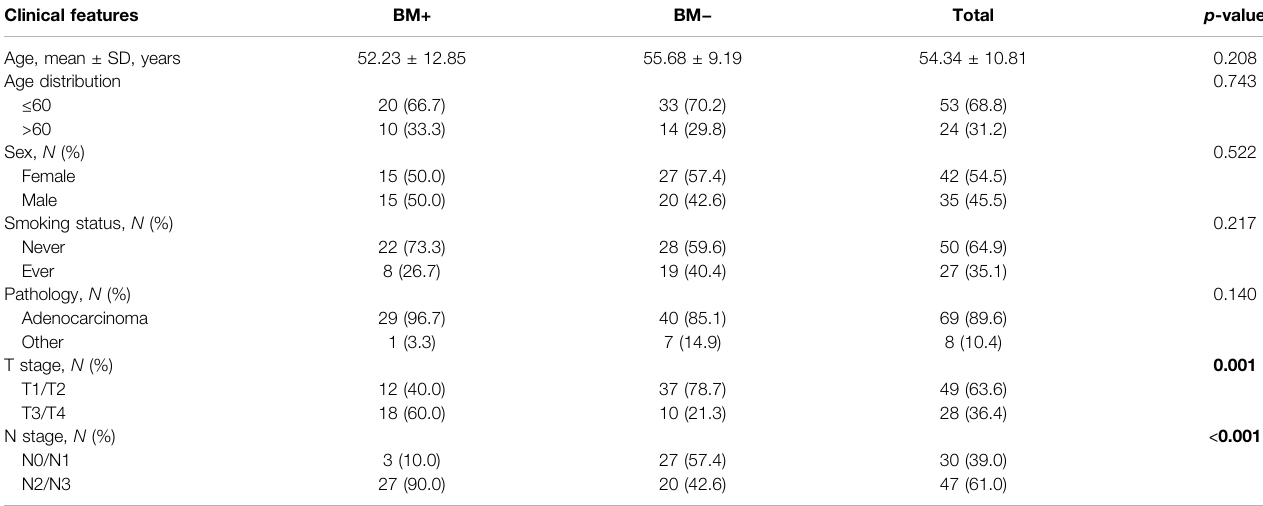
TABLE 1 | Demographic and clinical features of the patients. Clinical